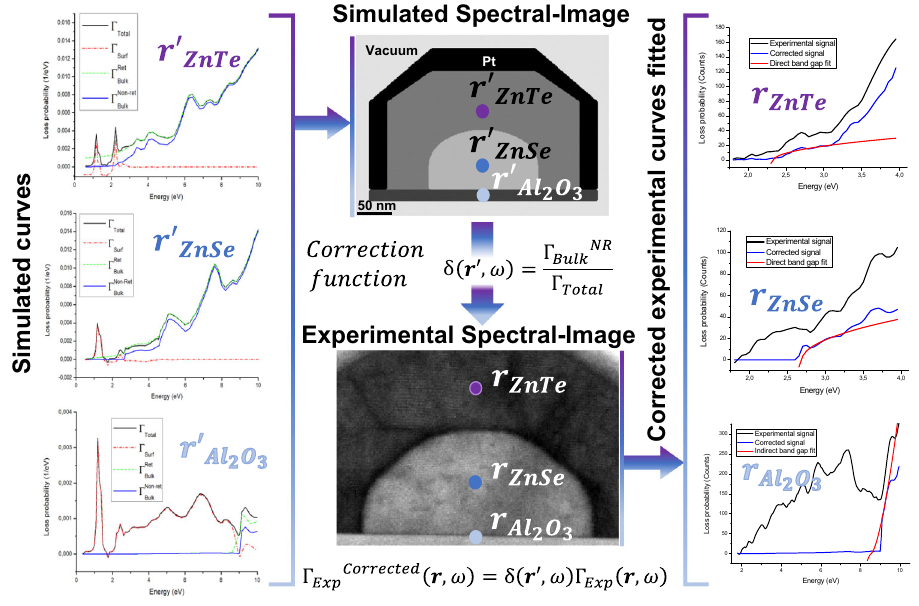
Fig. 4 Work fl ow of the developed method for correcting the measured low-loss Electron Energy-Loss Spectroscopy (EELS) data affected by Cherenkov radiation and surface modes. Classical electrodynamics simulations are used to produce a spectral image of both the non-retarded and retarded loss probabilities, which are by construction decomposed into bulk and surface contributions. Next, a correction function that compares the simulated non- retarded and retarded losses is used to map the effect of parasitic radiation and to clean the experimental spectral image. Finally, the corrected experimental signal is used to fi t either a direct or indirect band-gap structure depending on the material and spatial position, and to extract a band-gap value from such fi